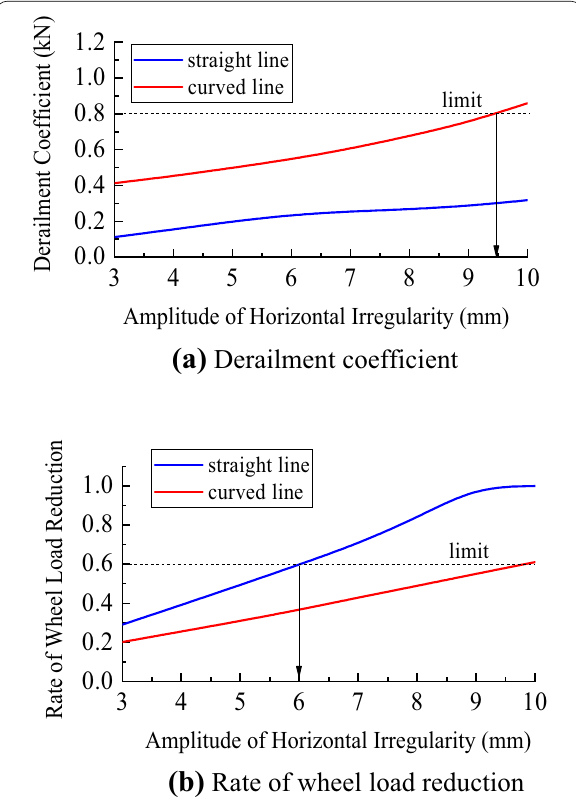
Figure 12 Influence of variation in cross-level irregularity wavelength amplitude on the rate of wheel load reduction and derailment coefficient under straight and curved operational line